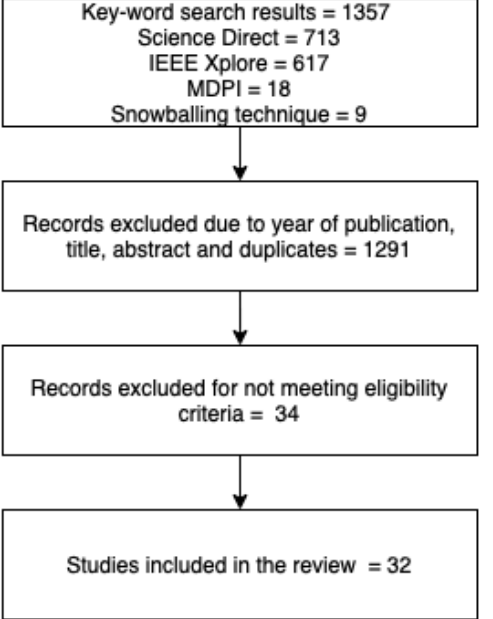
Figure 2. Flowchart of the selection process for the systematic review.